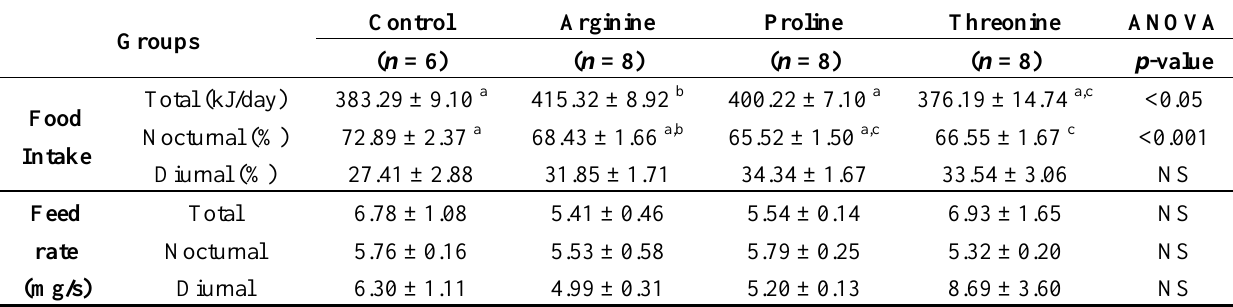
Table 6. Food intake and feed rate of rats fed on diets supplemented with 5% arginine, proline or threonine.